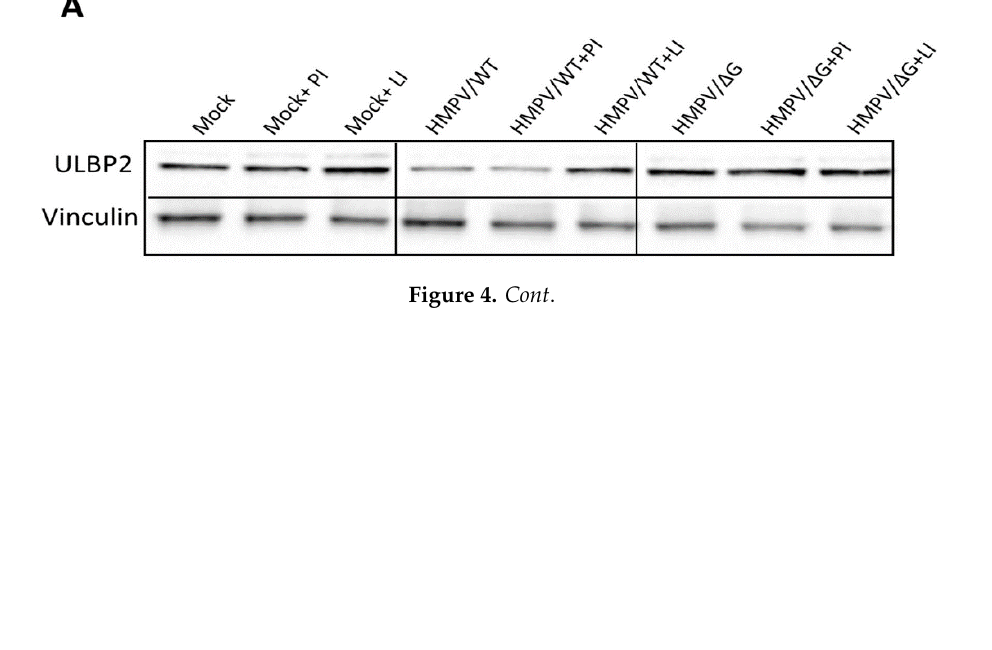
Figure 4. UL16 binding protein-2 ( ULBP2) total expression following HMPV infection. ( A ) Western Blot analysis of ULPB2 (28 kDa) expression in mock-infected A549 cells (Mock), HMPV/WT-infected A549 cells (HMPV/WT), and HMPV/∆G - infected A549 cells (HMPV/∆G) with or without treatment with proteasome and lysosome inhibitors (PI, LI, respectively) (upper panel). Vinculin was used as a loading control (lower panel) (124 kDa). ( B ) Quantification of the relative ULBP2 protein levels shown in ( A ): protein quantity was normalized by vinculin expression, and then the ratio of ULBP2 levels for each treated cells was calculated as follows: (level in treated cells)/(level in mock-infected cells). The figure shows one representative experiment out of three independent experiments performed. Statistical analysis was calculated on the data from all experiments combined using two-way ANOVA ( n = 3). p values were estimated using a post-hoc test. * p < 0.01 and ** p < 0.005. 3.3. The HMPV Protein M2.2 Targets Major Histocompatibility Complex (MHC) Class I Polypeptide- Related Sequences A and B (MICA) and (MICB) The HMPV genome is comprised of a negative-sense single-stranded RNA, containing eight genes that encode for nine proteins. The order of the genes in the genome is 3 ’ -N-P-M-F-M2-SH-G-L- 5 ’ . The proteins are: nucleoprotein (N), phosphoprotein (P), matrix protein (M), fusion glycoprotein (F), putative transcription factor (M2.1), RNA synthesis regulatory factor (M2.2), small hydrophobic glycoprotein (SH), attachment glycoprotein (G), and viral polymerase (L) [31]. To test if any of these proteins is responsible for the downregulation of the NKG2D ligands, we expressed all viral proteins labeled with an HA-tag in A549 cells. We succeeded in expressing all viral proteins except SH and L (see Western blot verifications in Figure 5A). The M2.2 protein is a small protein (8 kDa) that could not be detected using a Western blot and, therefore, the expression of this protein was verified by using intracellular Fluorescence-activated cell sorting (FACS) staining using a HA-specific antibody (Figure 5B). Staining of cells expressing the HMPV proteins or empty vector reveals almost no changes in the expression of MICA, MICB, ULBP1, ULBP2, and ULBP3, while expression of M2.2 was sufficient to reduce the expression of MICA and MICB. These results imply that the G protein is necessary for the downregulation of ULBP2 but not sufficient. Additionally, the downregulation of ULBP2 and ULBP3 occurred likely through a combination of more than one HMPV proteins.